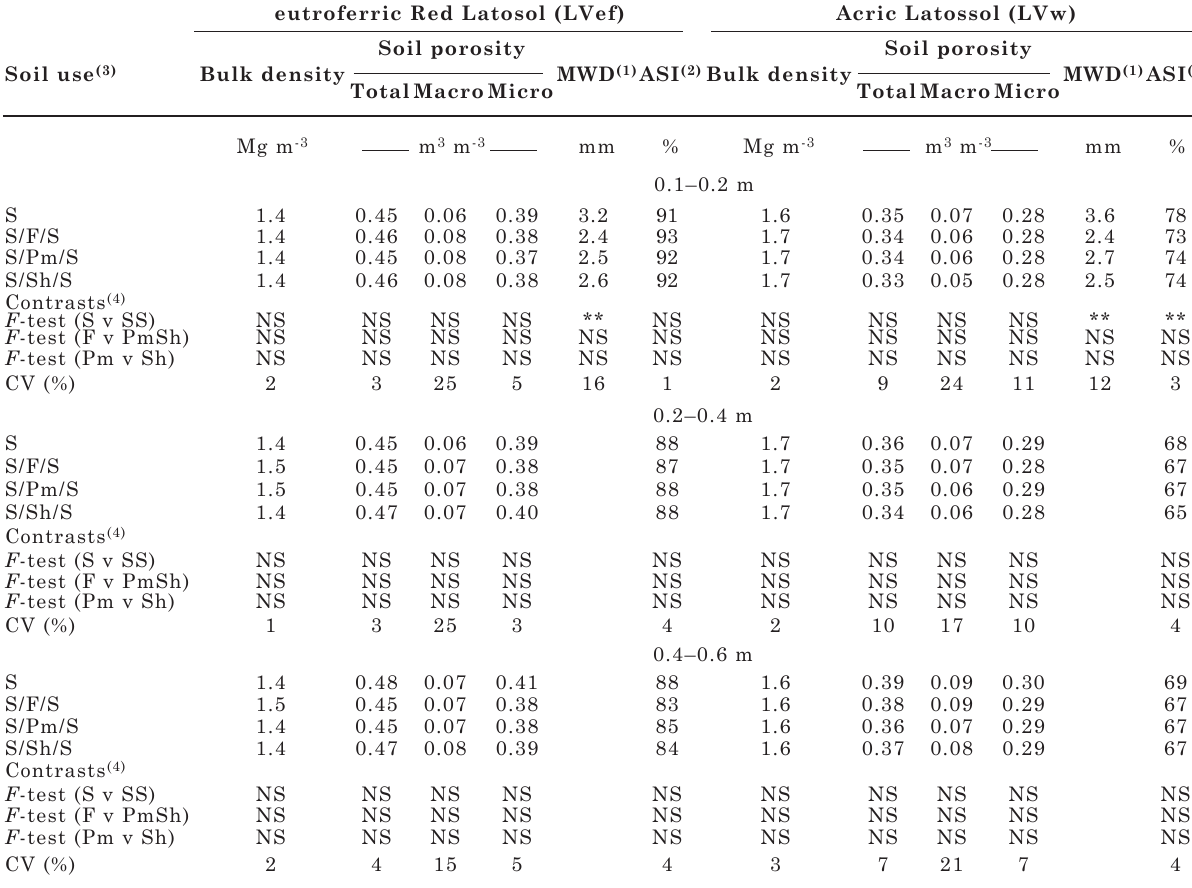
eutroferric red latosol